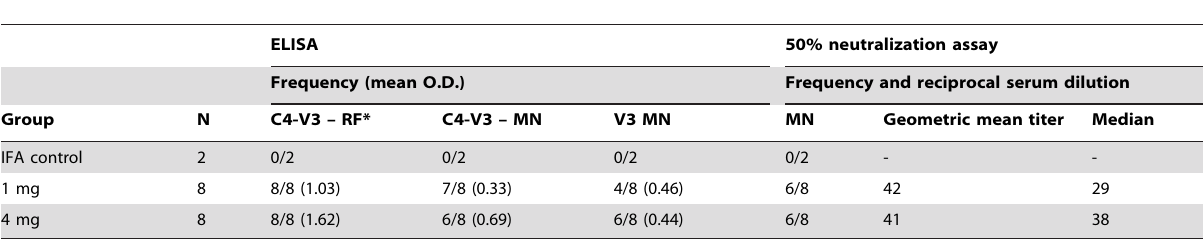
Table 4. Antibody response on day 56 in subjects who received 2 doses.